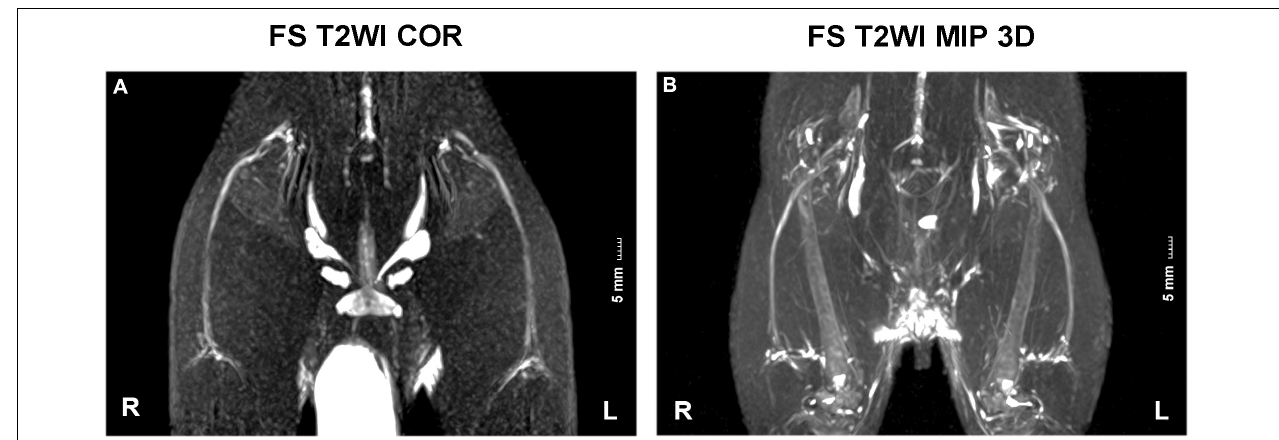
FIGURE 1 | FS T2WI COR and MIP 3D images of sciatic nerves. (A,B) T2WI coronal view displayed the morphology of bilateral sciatic nerves. They split above the knee joint into tibial and peroneal nerves. R, right hind limb; L, left hind limb. Scale: 5 mm.